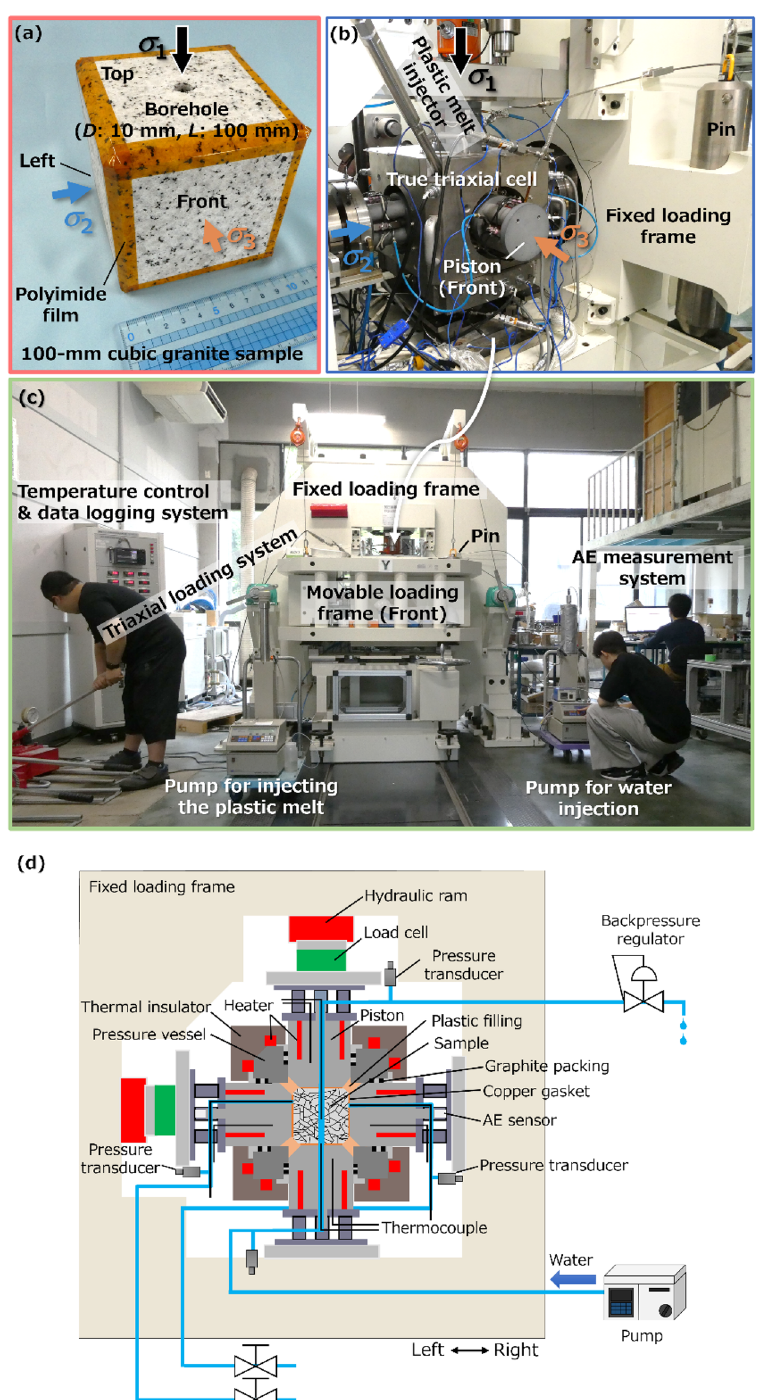
Fig. 2 Photos of the granite sample ( a ), true triaxial cell ( b ), and experimental system in the borehole cooling experiment ( c ), together with a schematic illustration of the experimental system ( d